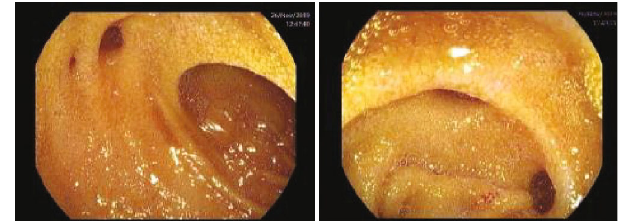
Figure 4: Postoperative enteroscopy depicting multiple